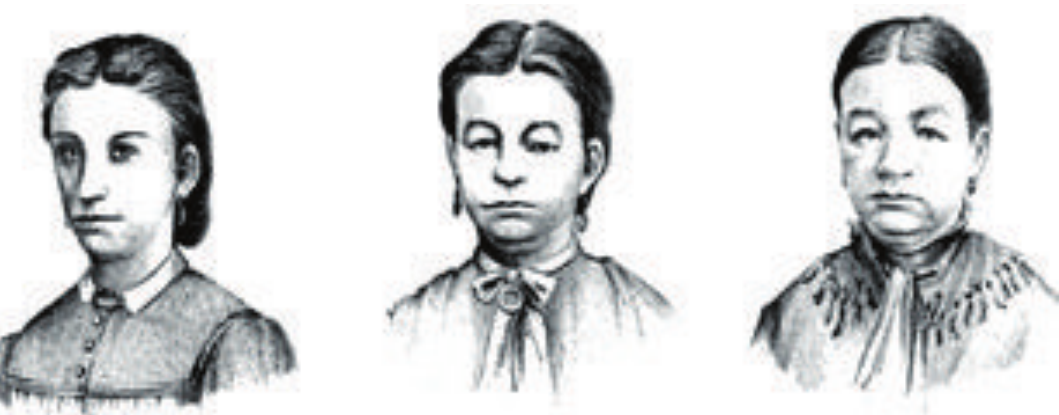
Figure 1: First photo of a patient with myxedema. From Ord (1878). (a) Patient at the age of 21—before onset of symptoms. (b) Seven years later. (c) Four years later.